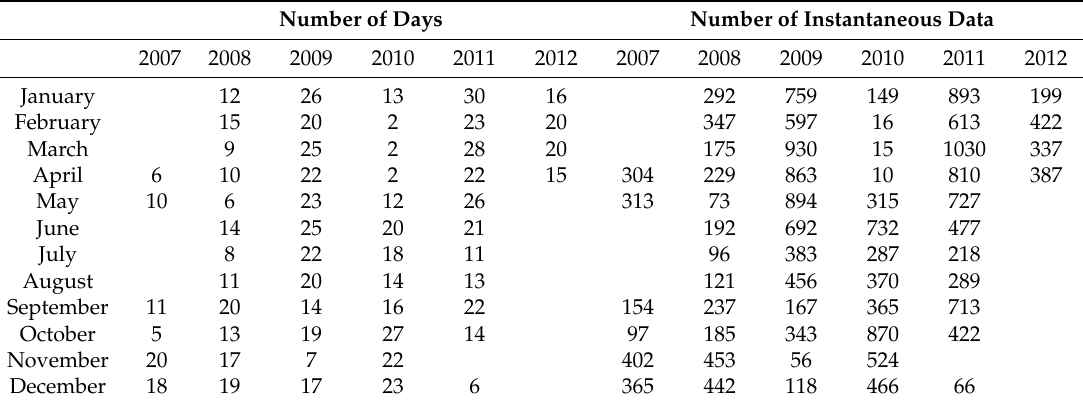
Table 1. Observation of numbers and days of level 1.5 sun direct data for AOD and Ångström exponent. Number of